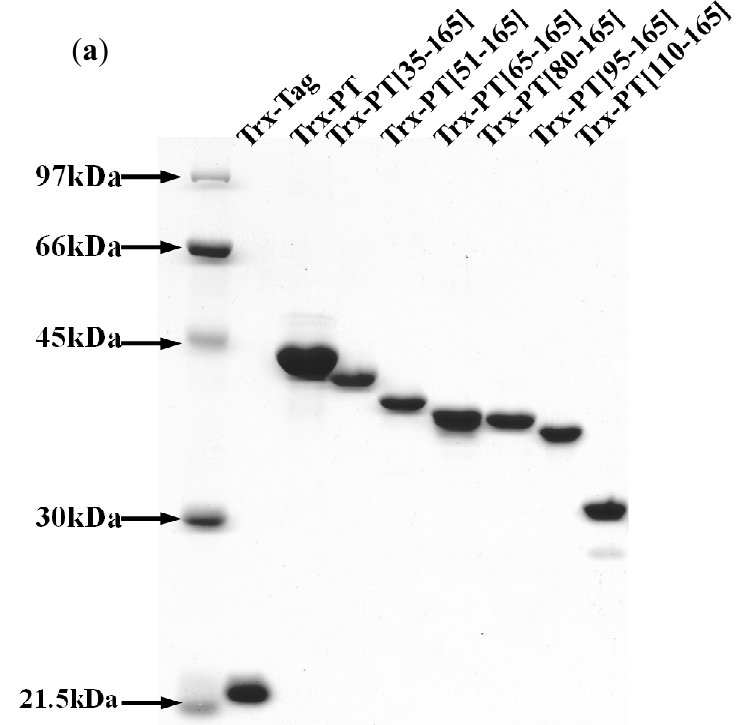
Figure 4. ( a ) SDS-PAGE (12.5%) analysis of phostensin and phostensin mutants, trx-PT(35–165), trx-PT(51–165), trx-PT(65–165), trx-PT(80–165), trx-PT(95–165) and trx-PT(110–165); ( b ) Single filament binding assay. Trx-PT, trx-PT(35–165), trx-PT(51–165), trx-PT(65–165), trx-PT(80–165), trx-PT(95–165) or trx-PT(110–165) was conjugated with Alexa-488 to emit green fluorescence after excitation. The gelsolin-capped actin filaments were labeled with rhodamine-phalloidin to emit red fluorescence after excitation. Trx-PT(51–165), trx-PT(65–165), trx-PT(80–165), trx-PT(95–165) or trx-PT(110–165) binds to the sides of gelsolin-capped actin filaments, while trx-PT or trx-PT(35–165) binds to the ends of the gelsolin-capped actin filaments. Under assay conditions, 96% of Alexa-488-labeled trx-PT(35–165) were localized at a filament end ( n = 55); approximate 93% to 97% of the other Alexa-488-labeled phostensin mutants were bound to the actin filaments ( n = 50–104). The bar represents 3 μ